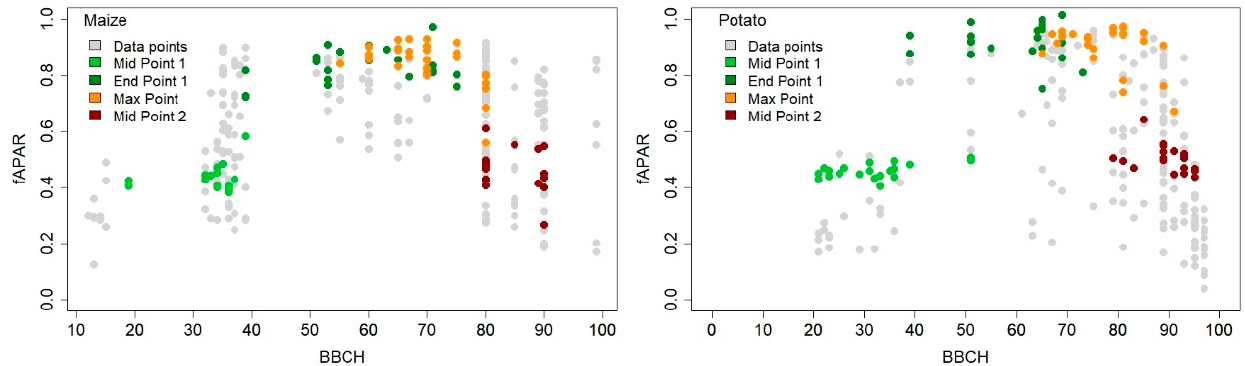
Figure 13. Examples of model fit of fAPAR for two maize, potato, and wheat fields during the 2017 season. The red squares depict the inflection points.